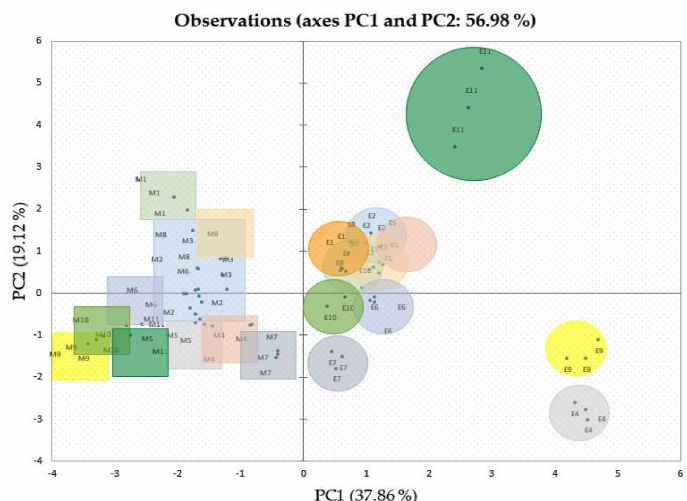
Figure 7. Principal component relationships of fungal filtrate and mycelium extract from eleven sooty molds isolates, with M and E indicating methanol and ethyl acetate. Abbreviations; E = filtrate (EtOAc) extract, M = mycelium (MeOH) extract, E1, M1 = CRC 98; E2, M2 = CRC 101; E3, M3 = CRC 102; E4, M4 = CRC 108; E5, M5 = CRC 110; E6, M6 = CRC 114; E7, M7 = CRC 117; E8, M8 = CRC 119; E9, M9 = CRC 120; E10, M10 = CRC 121; E11, M11 = CRC